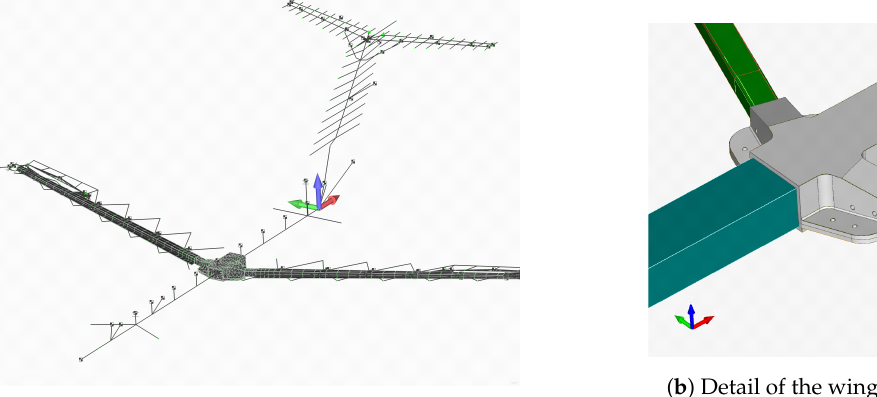
Figure 8. Detail of the upgrading of the stick